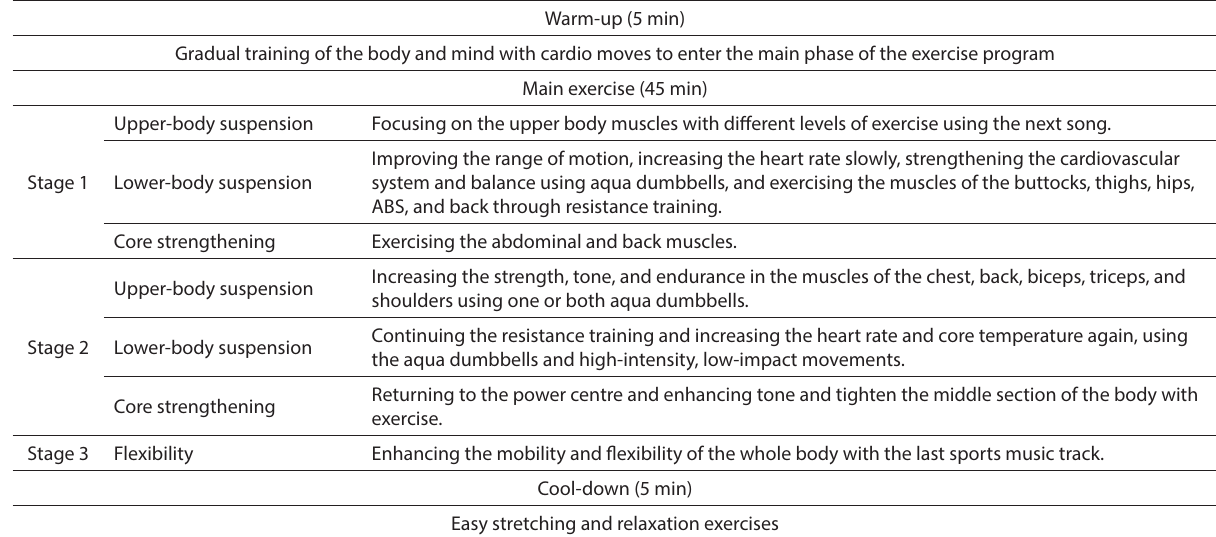
Table 1. The aquatics exercise program of WATERinMOTION